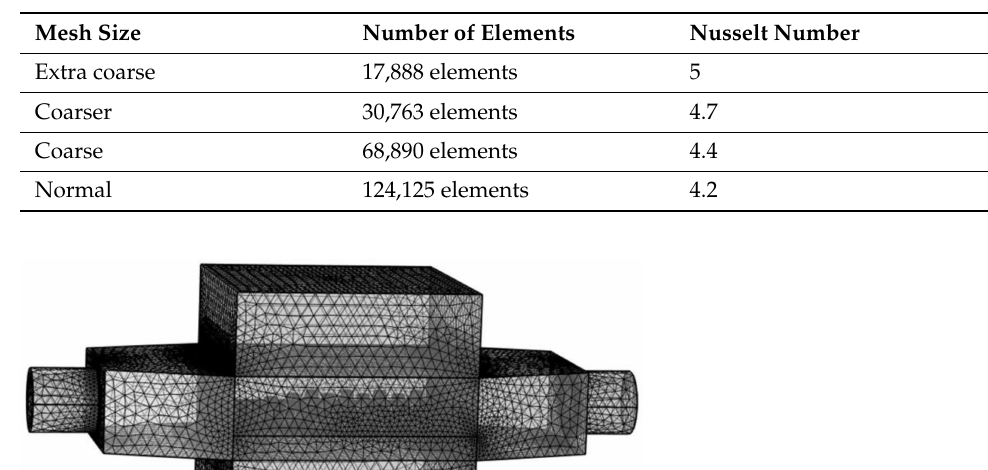
Table 2. Mesh sensitivity analysis.